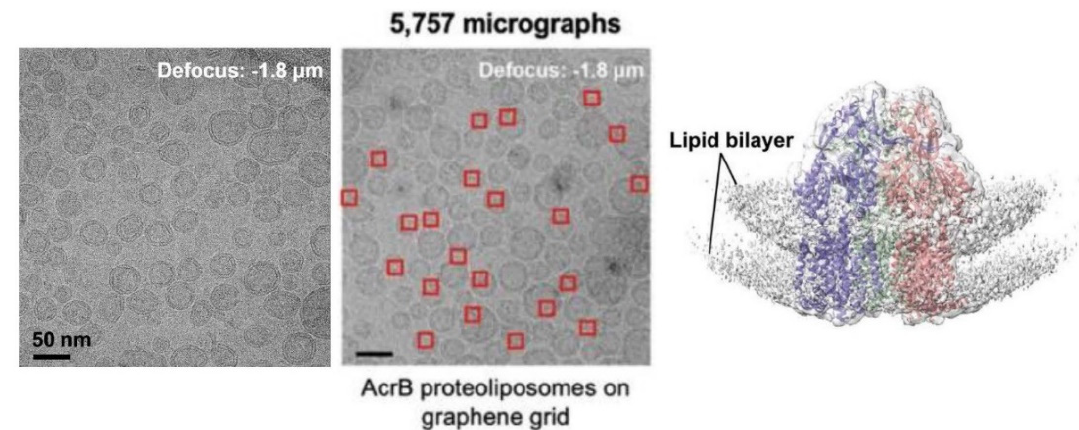
Figure 40. Application of LUVs for the reconstitution of membrane proteins. Determination of the structure of a vesicle membrane-embedded protein by cryo-electron microscopy, as published by Yao et al. (2020) [527]. Left: Cryo-TEM image of POPC vesicles containing membrane-embedded multidrug-resistant transporter AcrB from Escherichia coli , prepared with the help of the detergent n -decyl- β -D-maltopyranoside and polycarbonate membrane extrusion; see text and [527]. Middle : Example for the selection from a total of 5757 recorded movies of AcrB protein particles embedded in the vesicle membranes that could be used for the analysis of the protein structure. Right : Visualization of the structure of AcrB within the bilayer of a vesicle with the localization of the vesicle bilayer. See [527] for details. Reproduced from [527], copyright © Yao et al.